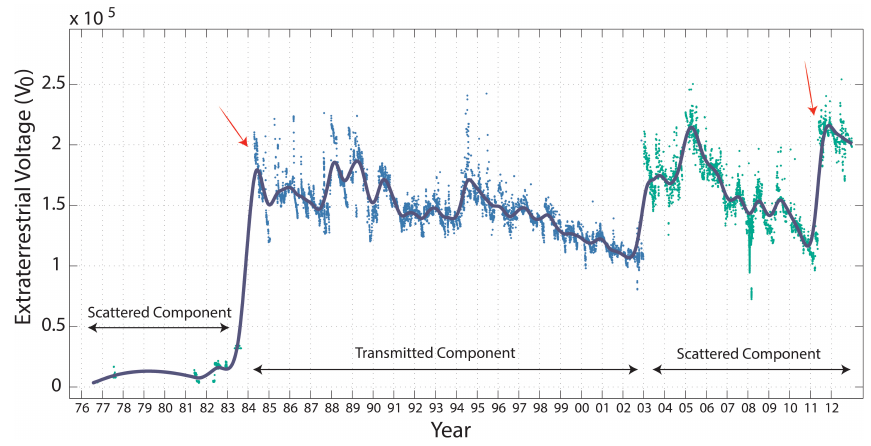
Figure 3. Mark-I extraterrestrial voltage ( V 0 ) variation extracted from the scattered (in green) and the transmitted component (in blue) within the period 1976–2012. The smoothing cubic spline is displayed with the violet line. Red arrows mark a change in the PMT of Mark-I. Table 1. Definitions of the statistics used in this study: f i represents the variable under validation, and Obs i the reference value. Statistics Score Equation Range Perfect